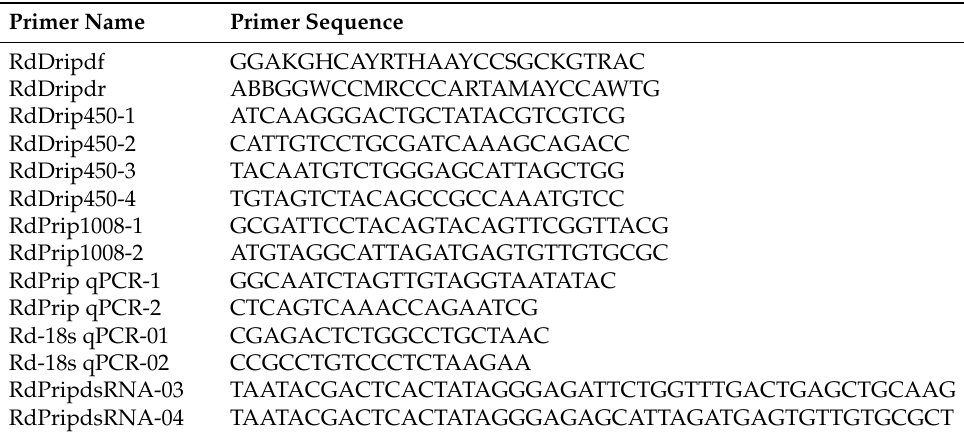
Table 1. Sequences of primers used in this